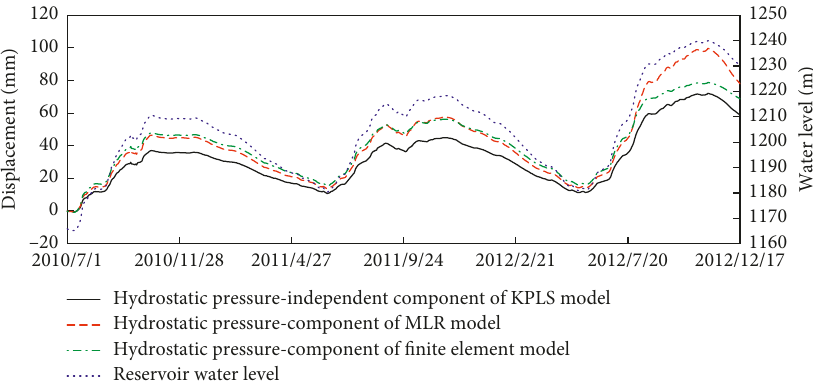
Figure 10: Comparison of the hydrostatic pressure components of models for radial displacement.